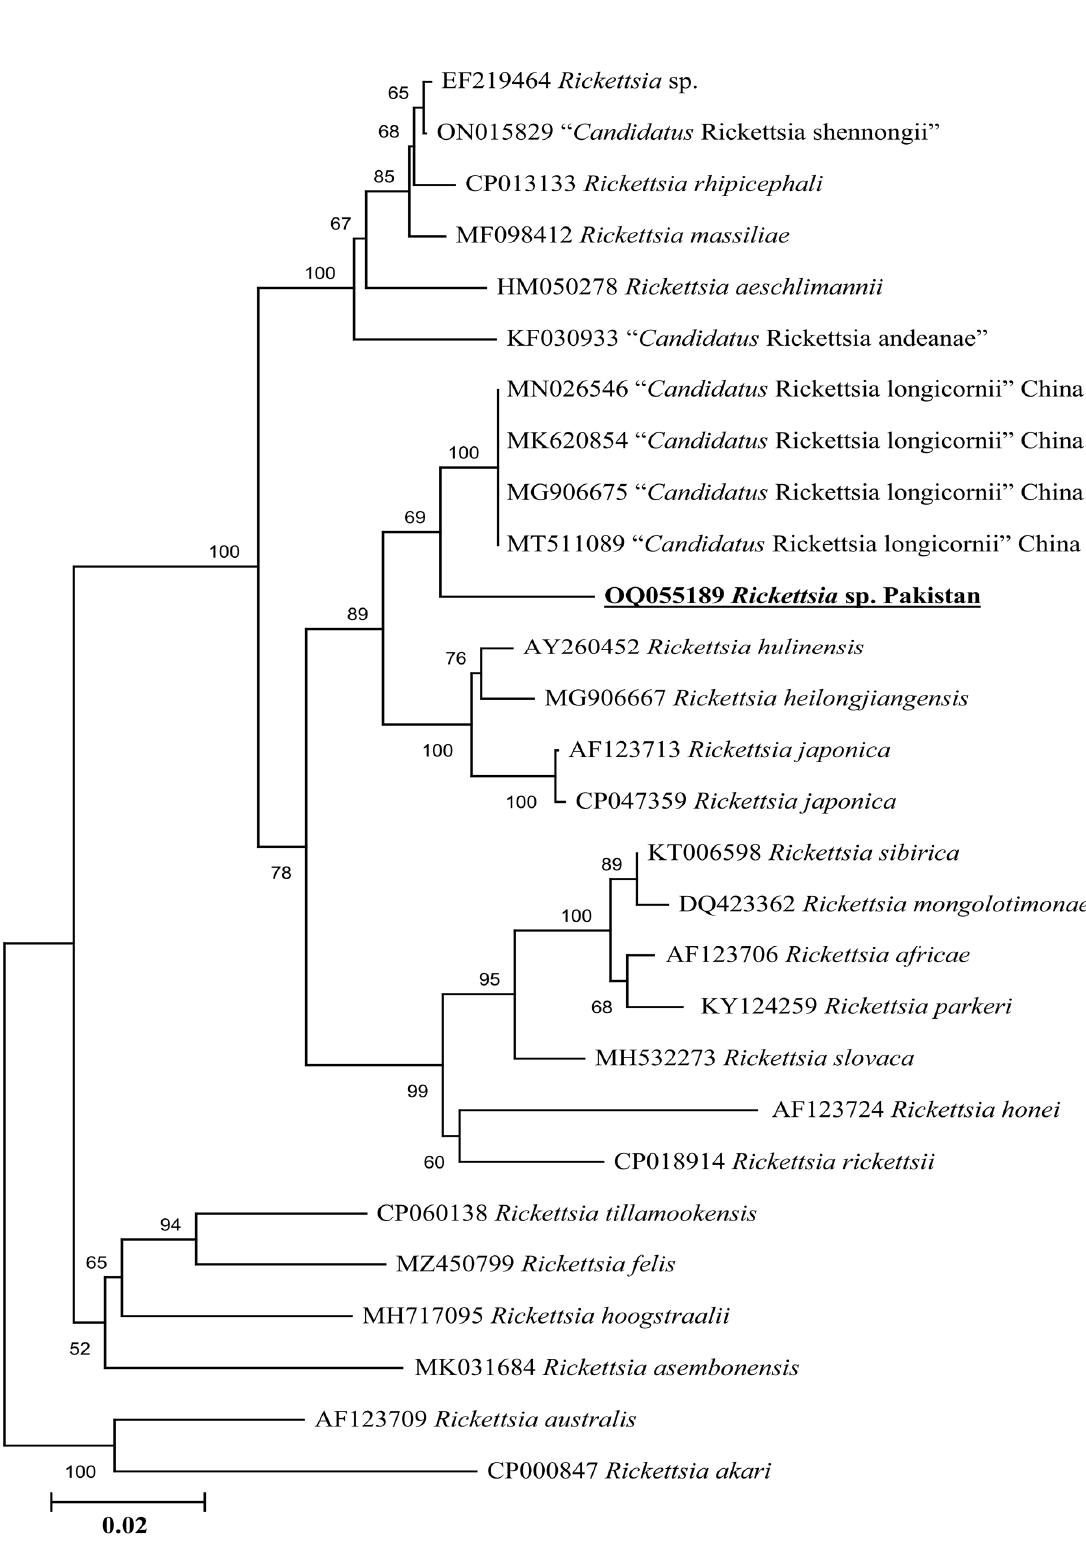
Figure 7. Neighbor ‐ Joining phylogenetic tree based on ompB sequences of a Rickettsia sp. The ompB sequences of R. australis and R. akari were employed as an outgroup. All sequences have been denoted by their GenBank accession numbers, followed by species name and country name. The bootstrap values (1000 ‐ replications) are shown at each node. The sequence (OQ055189) of the present study has been marked with bold and underlined fonts.